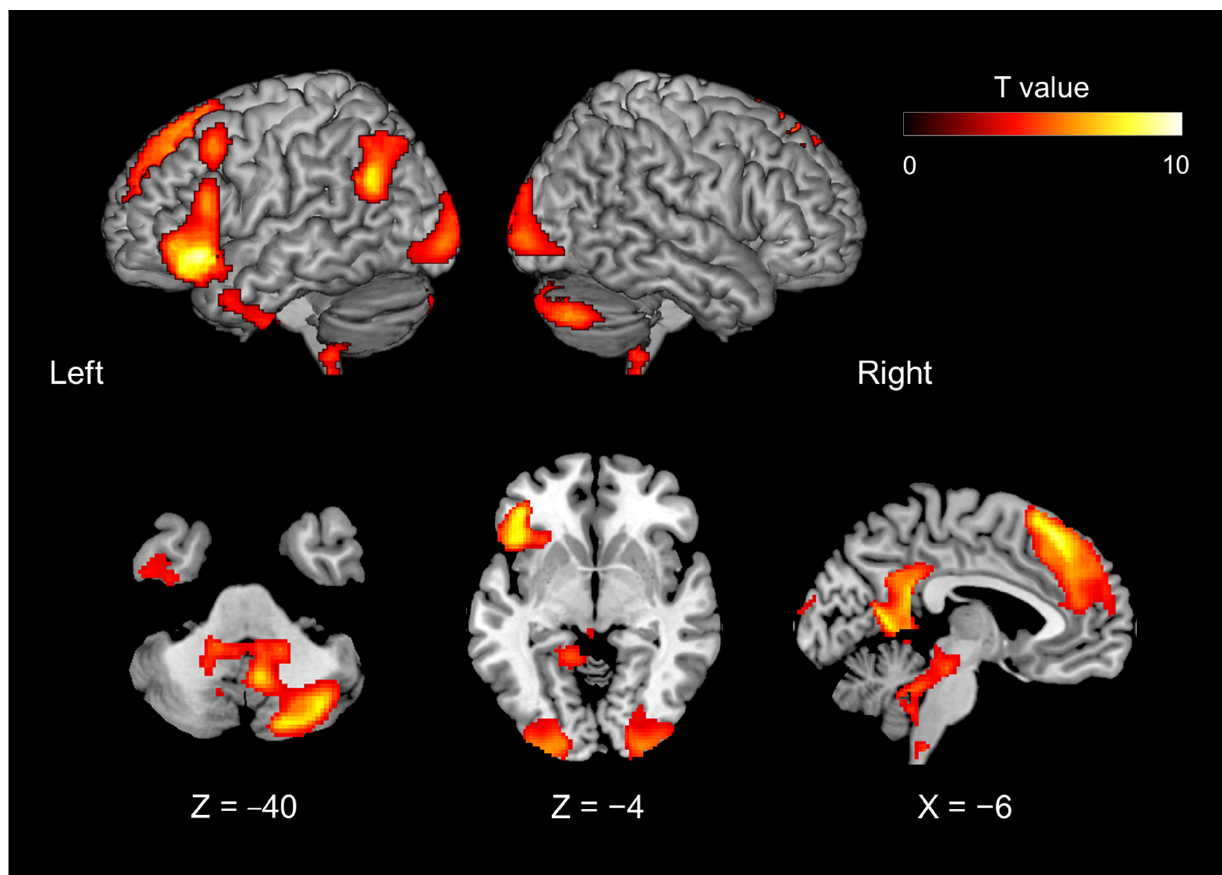
Figure 2. Brain activity during the evaluation phase of introspection (including both preference and familiarity judgments), contrasted with object feature identification (Contrast #3, Table 1).